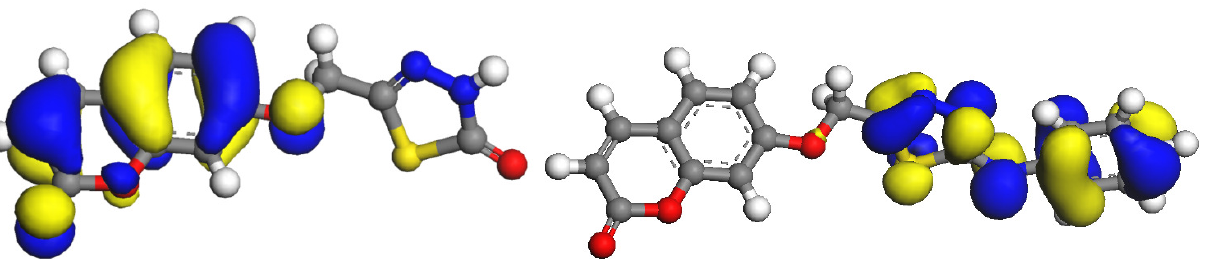
Figure 4. HOMO orbitals of 5 and 8 .